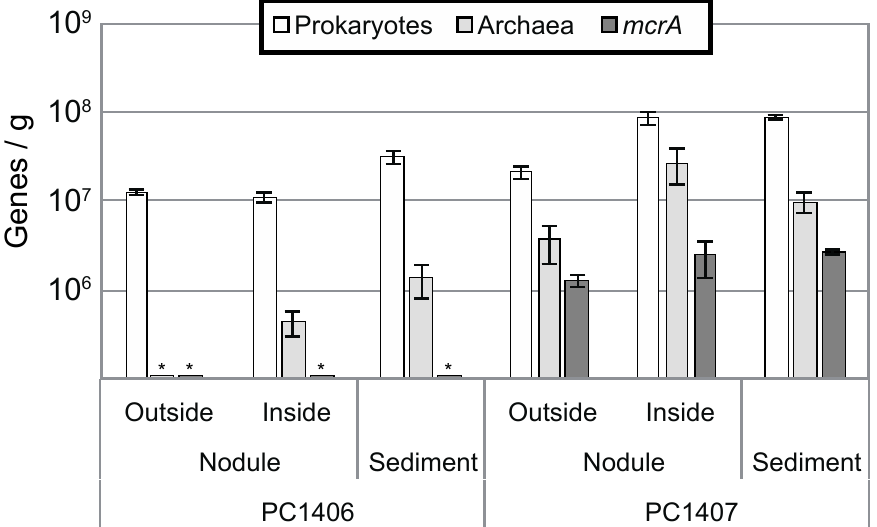
Figure 3. Numbers of 16S rRNA and mcrA genes in the nodule and adjacent sediment samples quantified by Q-PCR. An asterisk indicates below the limit of detection.